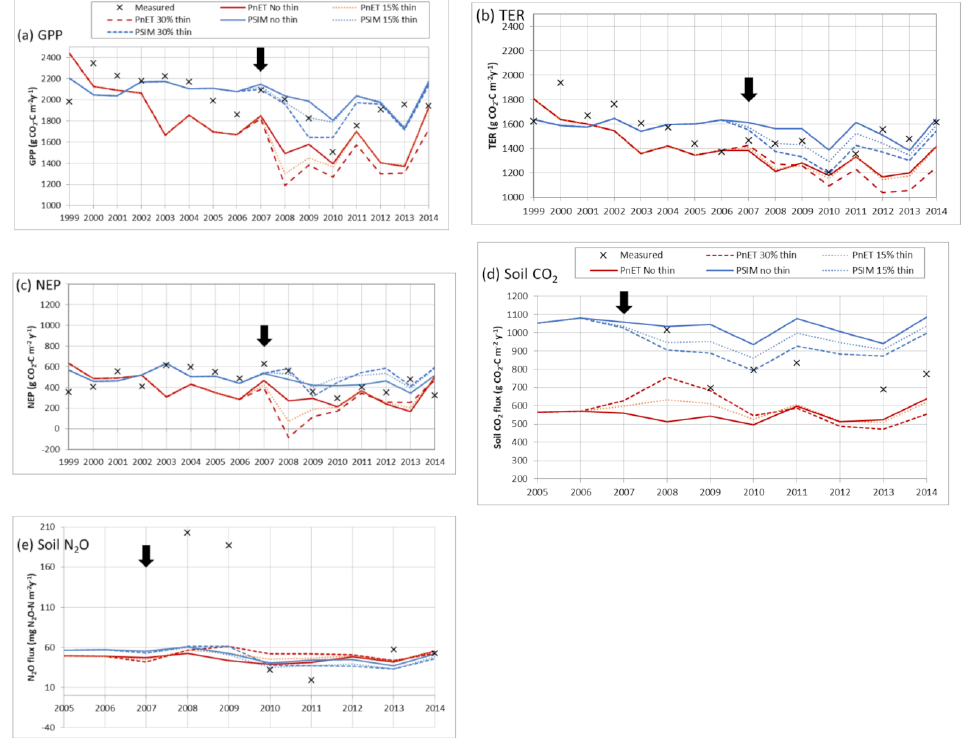
Figure 9. Annual eddy covariance CO 2 and soil gas flux measurements at the Straits Inclosure Tower Site for: ( a ) GPP, ( b ) TER, ( c ) NEP, ( d ) soil CO 2 and ( e ) soil N 2 O compared with simulated values from PnET, and PSIM with a 0%, 15% and 30% thinning event in September 2007 (marked with black